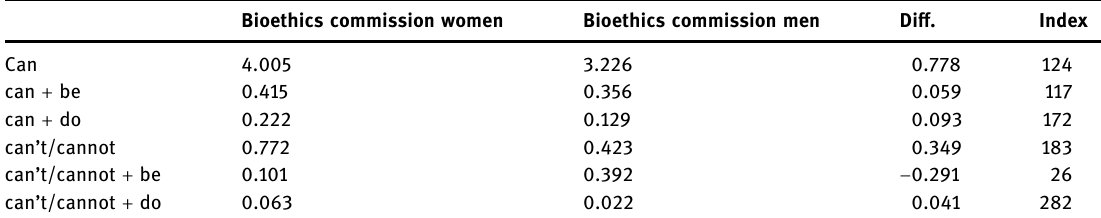
Bioethics commission women